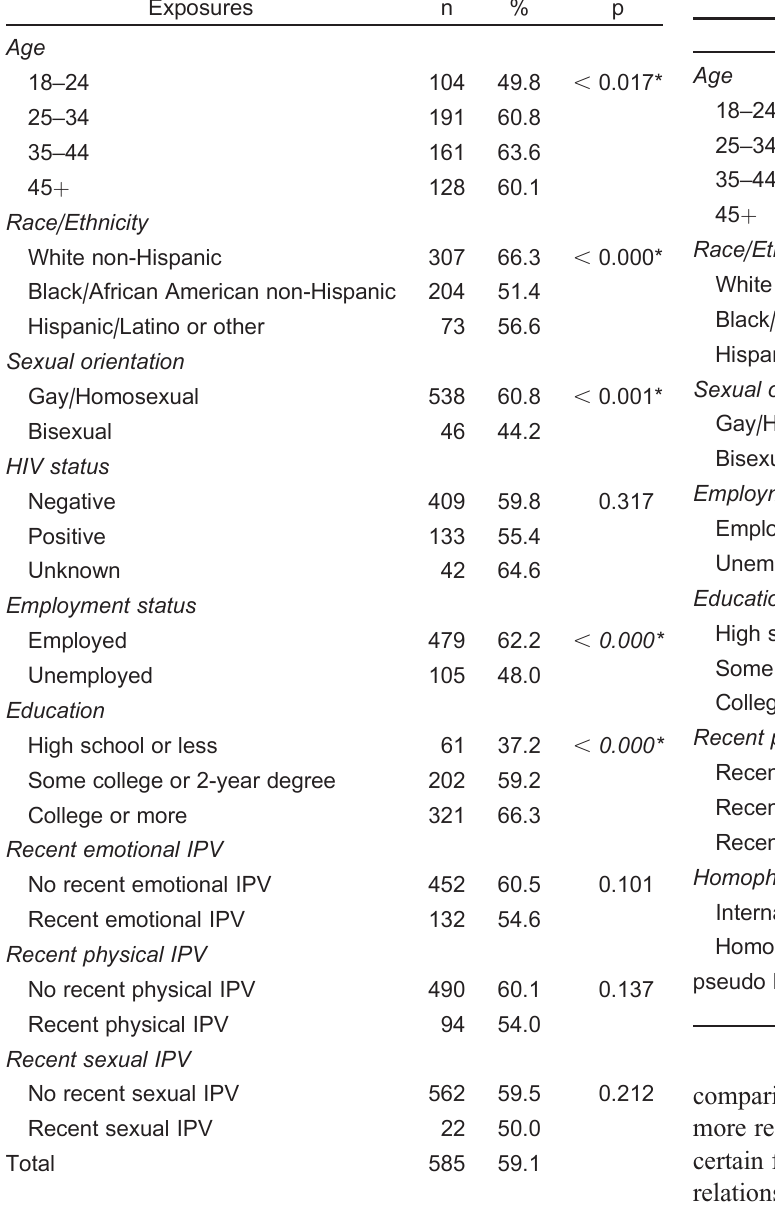
Table 5. Logistic regression results with odds ratios and (95% confidence intervals [CI]). Regression outcome was reporting that police would be less helpful towards a gay/bisexual man